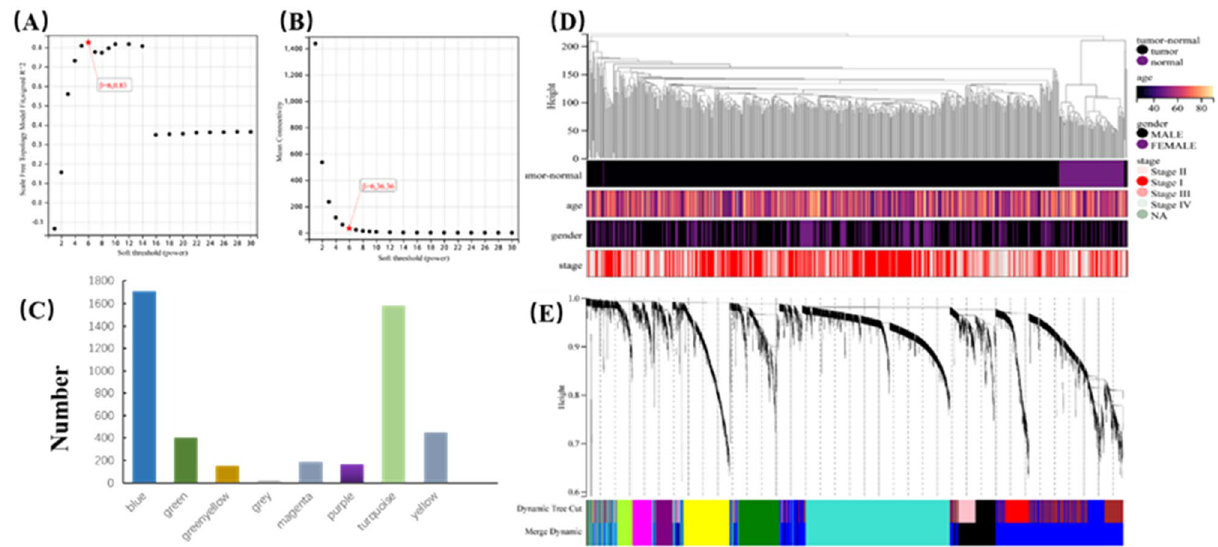
Figure 5. WGCNA of DEGs and identification of hub genes. ( A ) Scale independence. ( B ) Average connectivity. ( C ) Numbers of genes in the nine modules. ( D ) Clustering dendrogram of 578 samples. Black color represents ‘tumor’ for the variable ‘tumor-normal’; ‘Female’ or ‘Male’ for the variable ‘gender’; and ‘Stage I’, ‘Stage II’, ‘Stage III’, and ‘Stage IV’ for the variable ‘stage’. ( E ) Dendrogram. Each branch represents a gene, and each color represents a co-expression module.